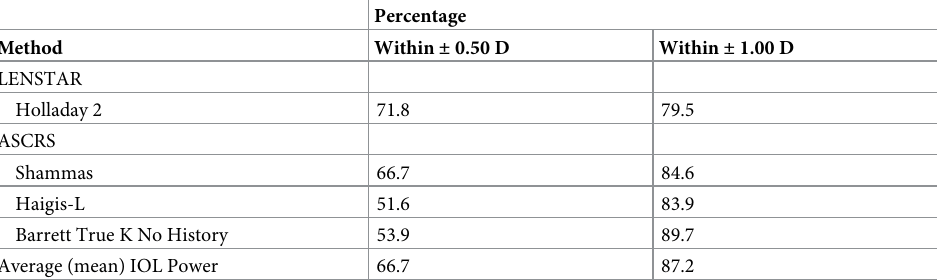
Table 5. Percentage of eyes within ± 0.50 D and ± 1.00 D of predicted refraction using various methods. Assuming that 1.0 D of IOL prediction error produces 0.7 D of refractive error at the spectacle